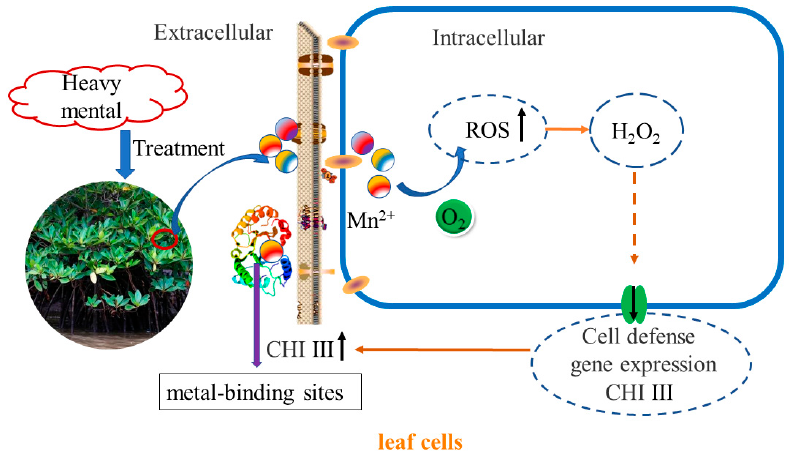
Figure 9. Concept map of chitinase action mechanism of mangrove plants under heavy metal